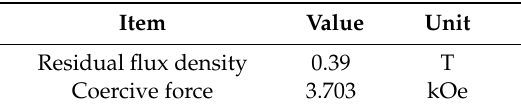
( b ) Figure 6. Rotor structure of LS-SynRM with end-ring ( a ) rotor and ( b ) view of A.